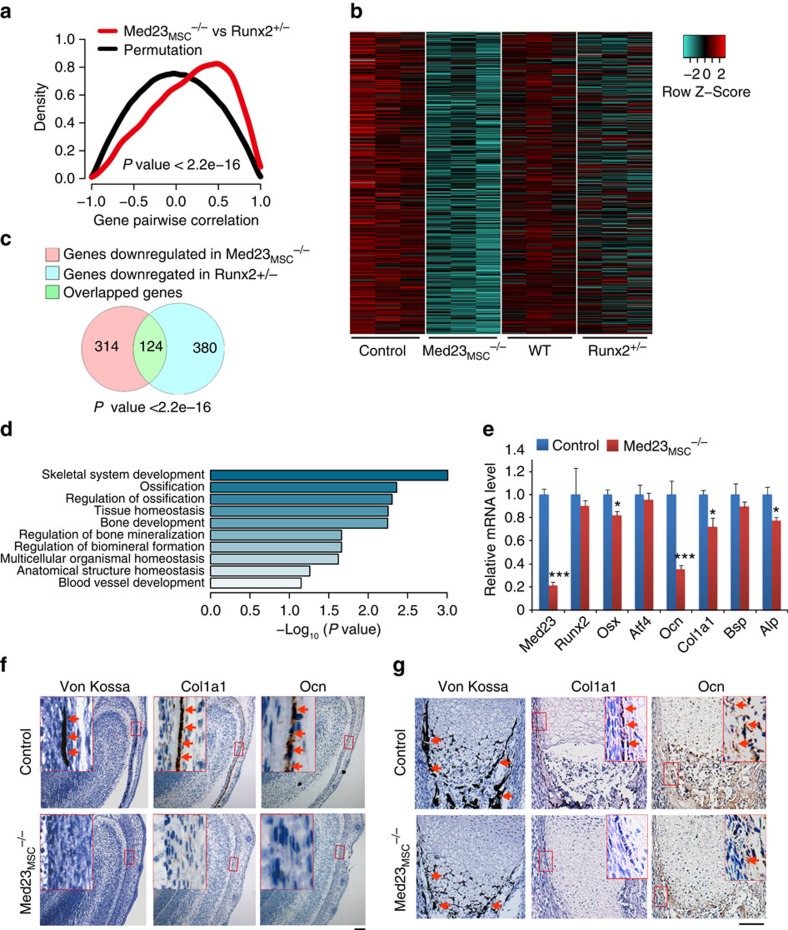
Med23 regulates expression of genes for osteoblast development.(a) Pair-wise correlation analysis of global gene expression in control versus Med23MSC−/− (Med23MSC−/− set) and in WT versus Runx2+/− (Runx2+/− set). Total RNAs were isolated from calvaria bone of control and Med23MSC−/− newborns and WT and Runx2+/− newborns, followed by RNA sequencing analysis. Kolmogorov–Smirnov (K–S) test was used for testing for correlation between Med23MSC−/− set and Runx2+/− set. (b) Heat map analysis of downregulated genes in Med23MSC−/− set and Runx2+/− set. (c) Analysis of downregulated genes (log2 fold change>0.5) common to Med23MSC−/− set and Runx2+/− set. (d) Gene ontology (GO) enrichment analysis of downregulated genes (>1.5-fold) in Med23MSC−/− set. (e) Relative expression level of osteogenic marker mRNAs from parietal bones of P2 control and Med23MSC−/−. Data represent means±s.d. t-test, *P<0.05 and ***P<0.001. (f) Sections (4 μm) of skull tissues and (g) sections (4 μm) of tibia bone from E16.5 control and Med23MSC−/− embryos were analysed for bone mineralization by von Kossa staining (left), and for expression of Col1a1 (middle) and Osteocalcin (Ocn) (right) by in situ hybridization. Scale bar, 100 μm.